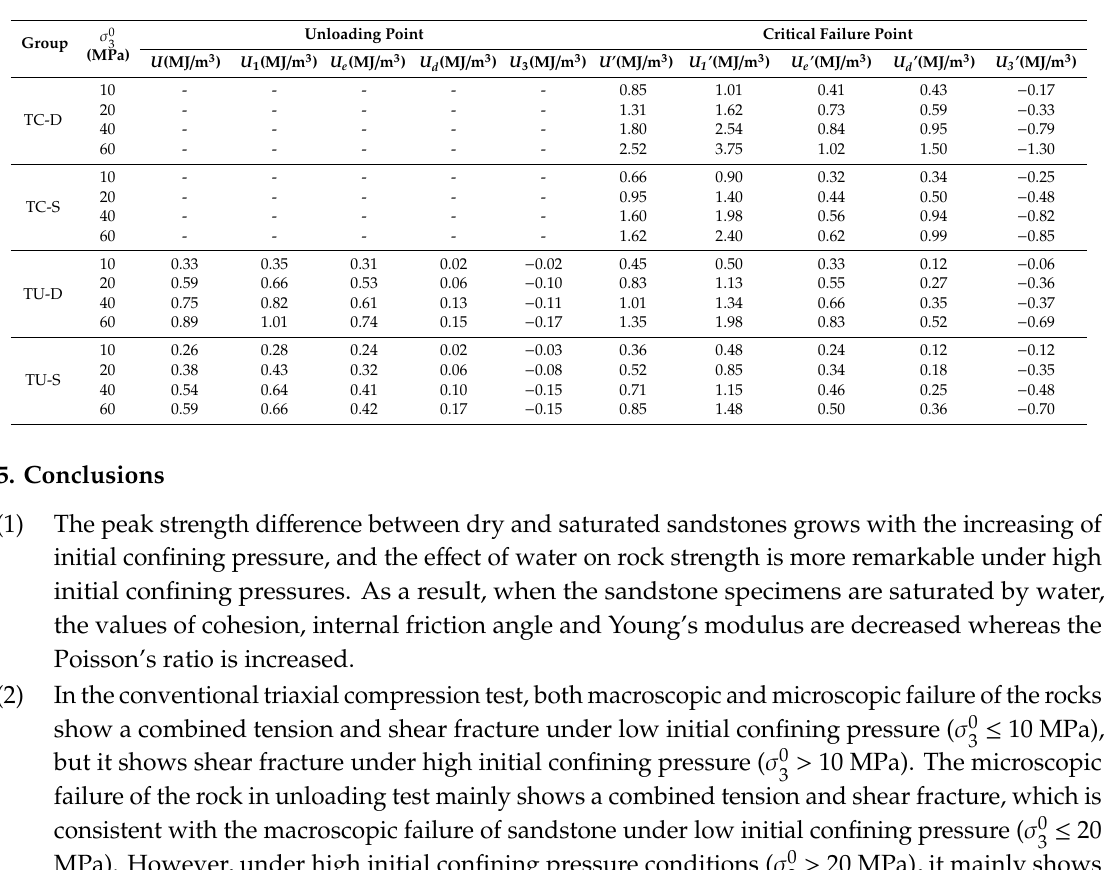
Table 4. Strain energy of sandstone specimens at the unloading point and the critical failure point in triaxial